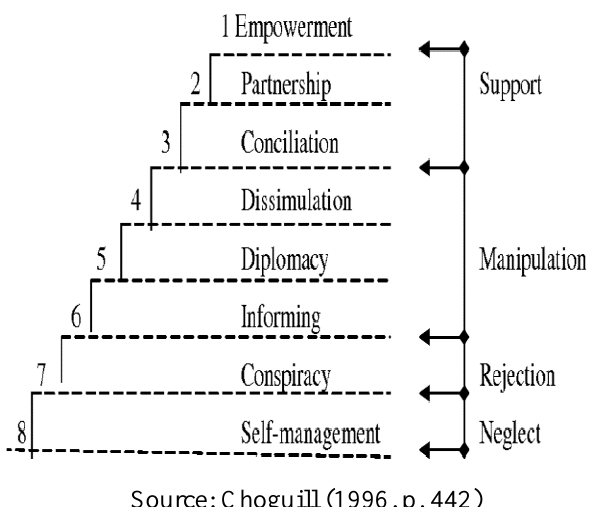
Figure 3: Choguill’s ladder of community participation